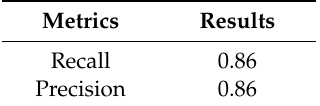
Table 7. Recall and precision values.